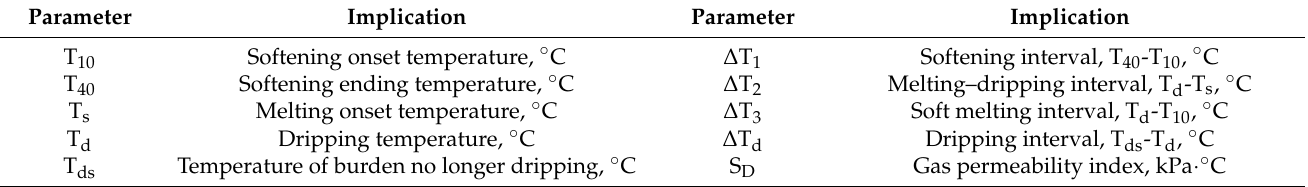
Table 3. Characteristic parameters for the softening–melting experiment.